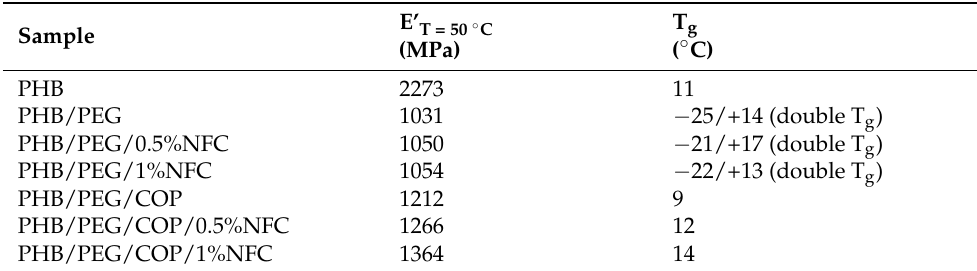
Figure 4. Results of the mechanical tests performed on PHB/PEG/COP/NFC composites: ( a ) stress– strain curves obtained from the tensile analysis; ( b ) stress–strain curves obtained from the flexural test; ( c ) Charpy impact strength and ( d ) Shore D hardness tests. Table 2. Storage moduli at 50 ◦ C (E’ T = 50 ◦ C ) and glass transition temperatures (T g ) of each formula- tion tested by dynamic mechanical